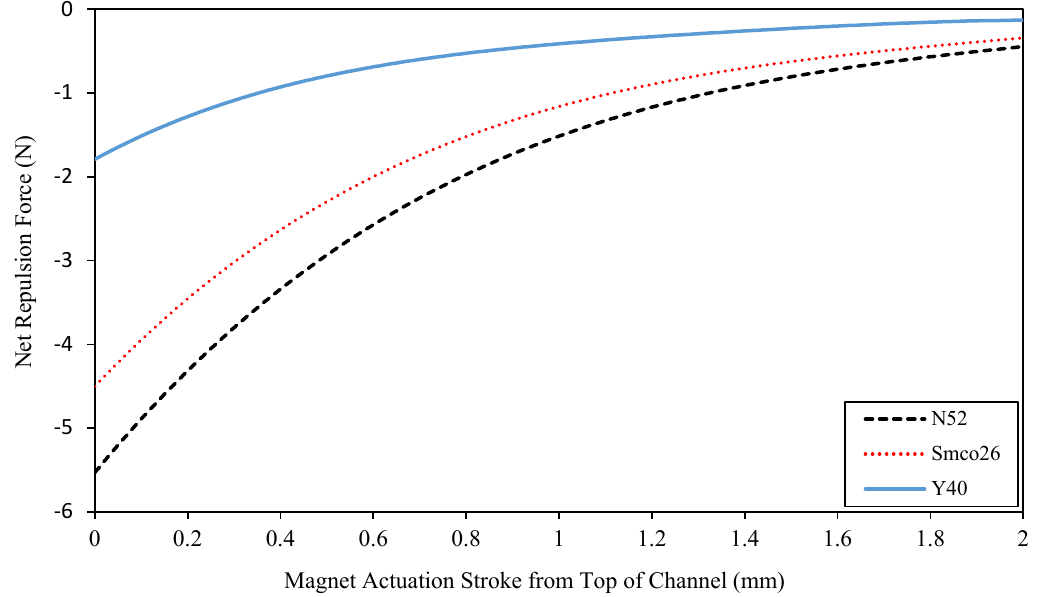
Figure 12. Net repulsion forces estimated on the three assessed permanent magnets during their stroke along the actuation stroke.